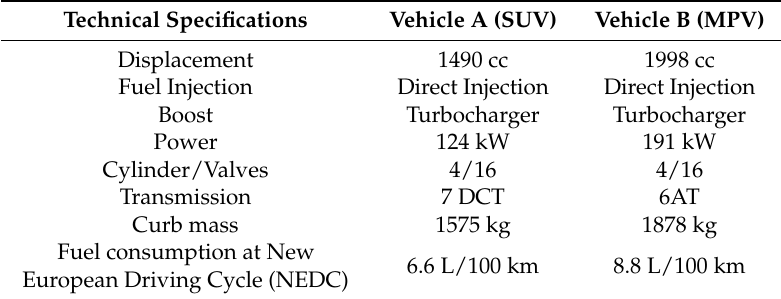
Table 2. Vehicle